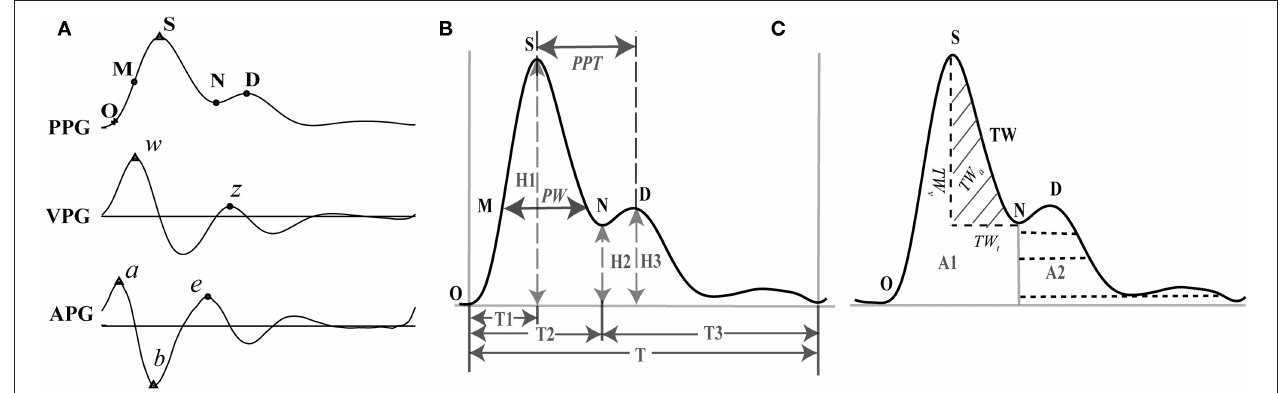
FIGURE 1 | Feature extraction of PPG and its derivatives. (A) Feature points on PPG, VPG (first derivative or velocity of PPG), and APG (second derivative or acceleration of PPG). (B) Representative features of the PPG. (C) Representative features of the PPG. O: onset of the systolic wave; S: the systolic peak; M: the midpoint of the systolic peak; N: the dicrotic notch; D: the diastolic peak; w: the maximum slope point in systole; z: the maximum slope point in diastole. a: the maximum acceleration point in systole; b: the maximum negative acceleration point in the falling edge; e: the maximum acceleration point in diastole. PW, pulse width corresponding to the midpoint of the rising phase; PPT, peak to peak interval between the systolic and diastolic peaks; TW, tidal wave; TW t , time range of TW; TW v , amplitude of TW; TW a , area of TW.